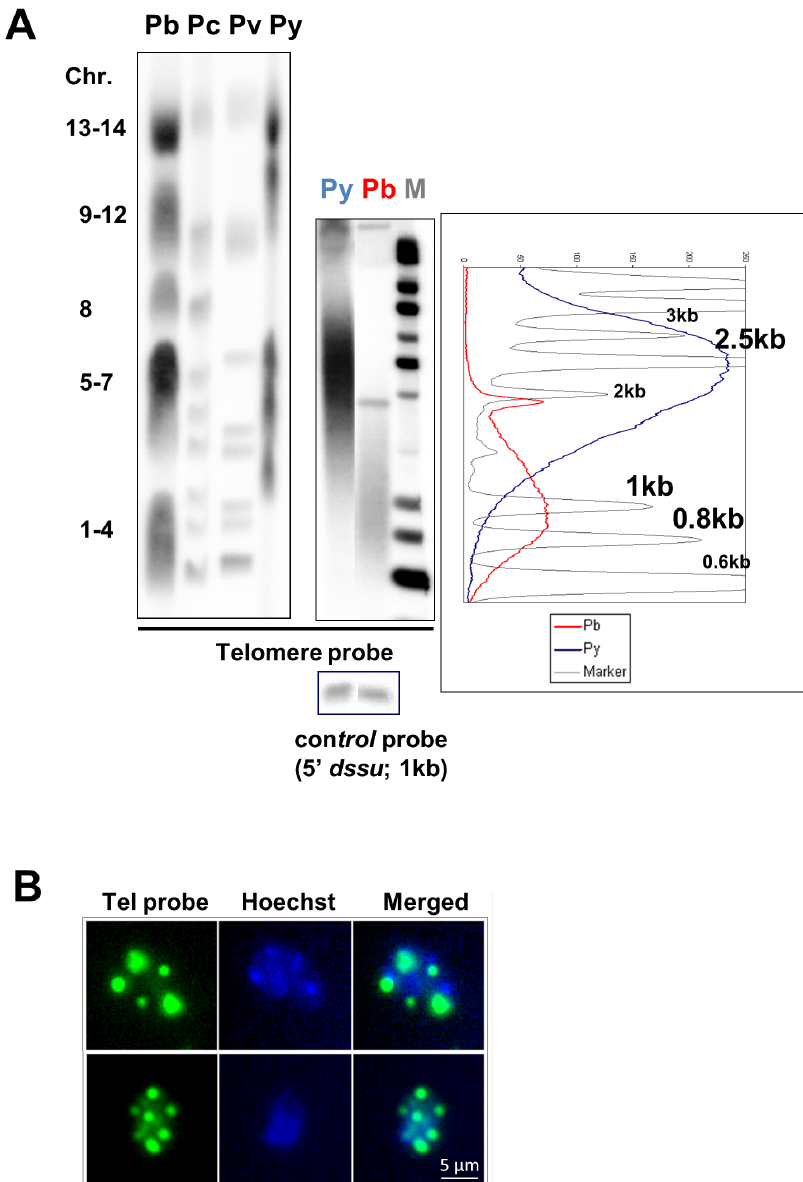
Figure 2. P.berghei telomere characterisation. (A) Determination of telomere length by Telomere Restriction Fragment (TRF) analysis. Left Panel: Southern analysis of separated chromosomes of P. berghei (Pb), P. chabaudi (Pc), P. vinckei (Pv) and P. yoelii (Py) showing hybridization of all chromosomes to a telomere-specific probe. The same probe was used for TRF analysis (middle, right panels). Middle panel: Southern analysis of digested P. yoelii (size control) and P. berghei gDNA probed with the telomeric probe showing the characteristic ‘‘smeared’’ hybridisation pattern in TRF analysis. Right panel: The average telomere length was measured as the highest peak of the signal intensity along the smear. Using the molecular marker (‘‘M’’, grey line) as a size reference (relevant marker bands sizes are noted on the graph), the mean telomere length was estimated to be , 2500 bp and , 950 bp for P. yoelii (blue line) and P. berghei (red line), respectively. Complete digestion of gDNA was confirmed by hybridisation with a 5 9 d-type small unit ribosomal RNA probe. (B) Fluorescence in situ hybridisation with a telomere-specific probe. Fixed late blood stages of P. berghei . The telomeric probe (1.5 kb) was labelled with fluorescein (green). Hoechst (blue) was used for nuclear staining. The size bar is 5 m m.